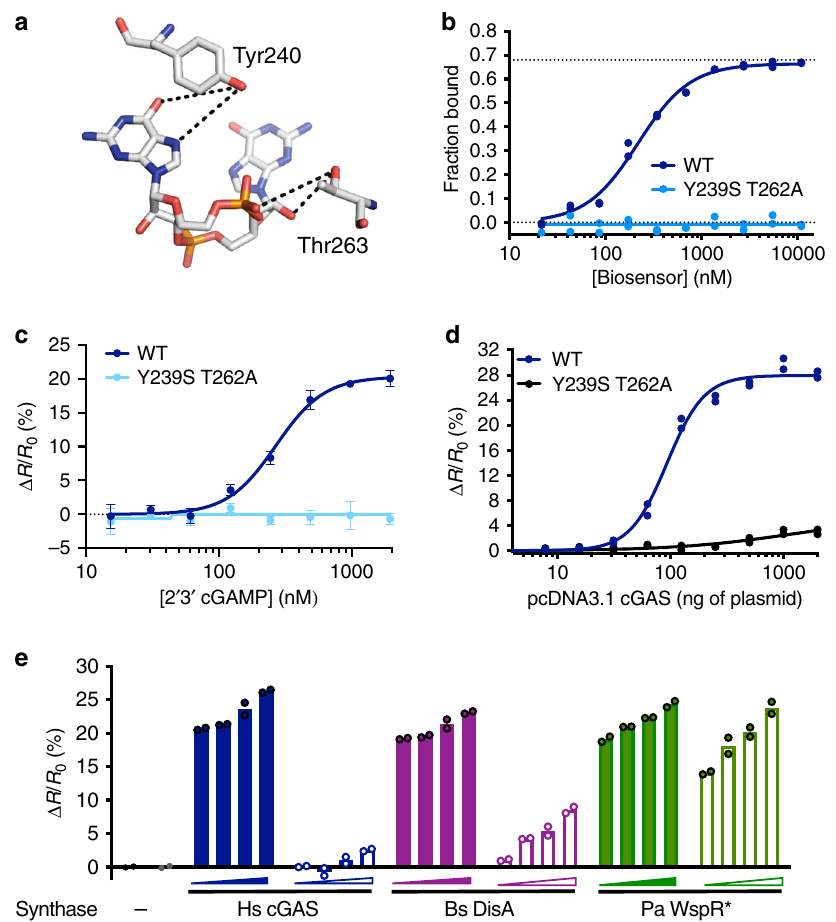
Fig. 4 BioSTING variants exhibit distinct speci fi city for metazoan and bacterial CDNs. a Interactions made by human STING residues Y240 (mouse Y239) and T263 (mouse T262) hypothesized to stabilize CDN binding in PDB 4F5D visualized in PyMol. b DRaCALA binding analysis of WT and Y239S T262A BioSTING using [ 32 P] labeled 2 ’ 3 ’ -cGAMP. c Recombinant WT and Y239S T262A BioSTING FRET response in the presence of increasing concentrations of 2 ’ 3 ’ -cGAMP. Data are presented as mean ± s.d. of n = 4 biological replicates. d HEK293T cells stably expressing WT or Y239S T262A BioSTING were transfected with increasing concentrations of pCDNA3.1-cGAS and analyzed for FRET response by fl ow cytometry. e HEK293T cells stably expressing WT (solid bars) or Y239S T262A (open bars) BioSTING were transfected with increasing concentrations (125, 250, 500, or 1000ng) of expression vectors for cGAS, DisA, WspR*, or empty vector and analyzed for FRET response by fl ow cytometry. Data in panels b , d and e are presented as individual data points of n = 2 biological replicates are